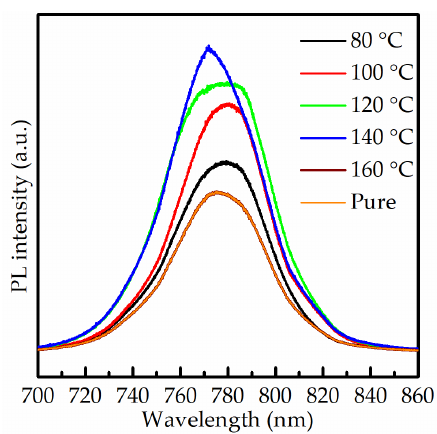
Figure 7. PL spectrum for CsPbI 3 -QDs doped perovskite thin films under different annealing temperatures in N 2 ambient and pure perovskite (MAPbI 3 ).